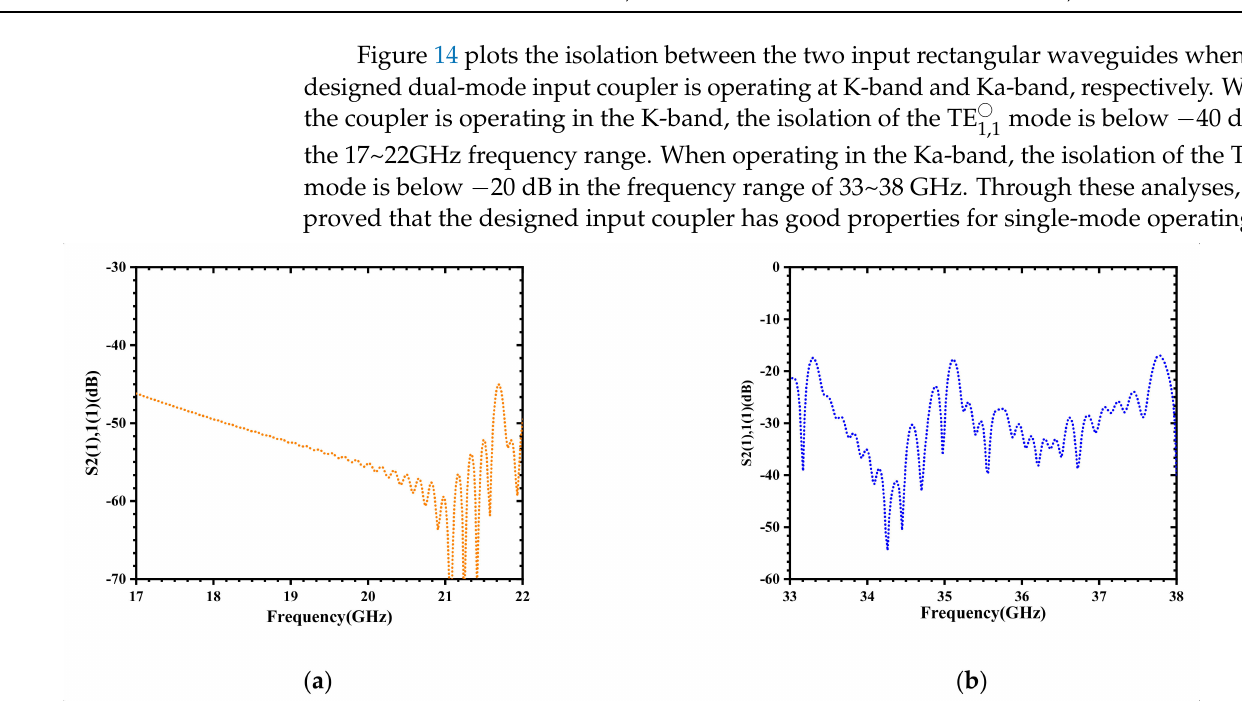
Figure 14. The isolation between the input rectangular ( a ) port 1 and ( b ) port 2 (ports 1 and 2 are labeled in Figure